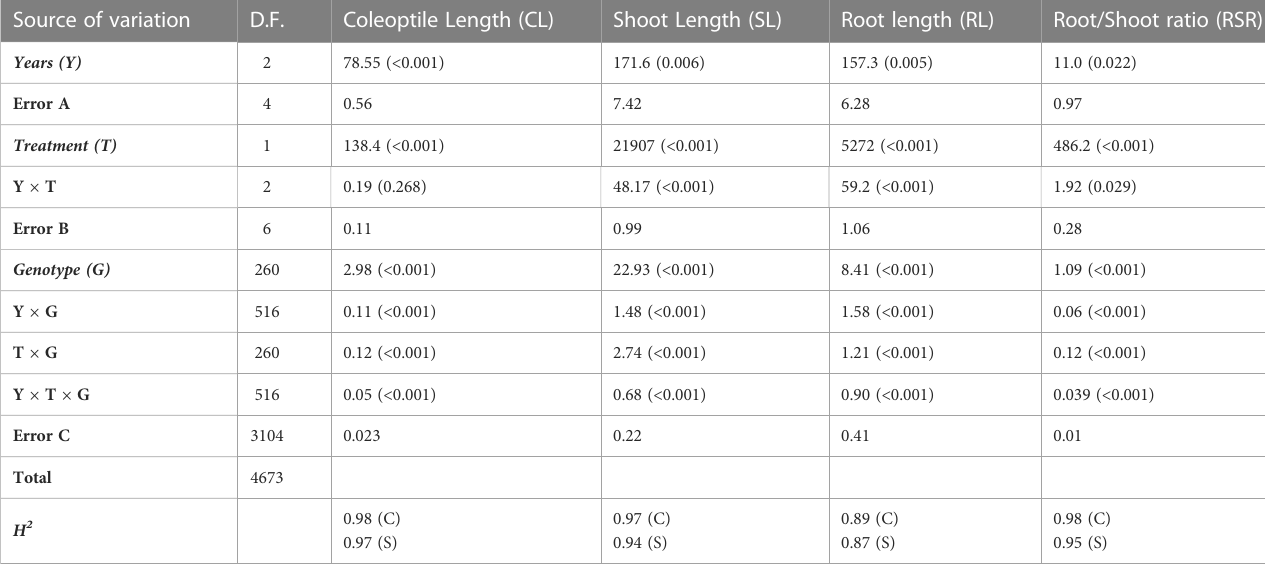
TABLE 1 Means square and p-value (ANOVA) of coleoptile length, shoot length, root length and root:shoot length in an experiment with two drought treatments evaluated on 261 wheat genotypes during 3 years. Source of